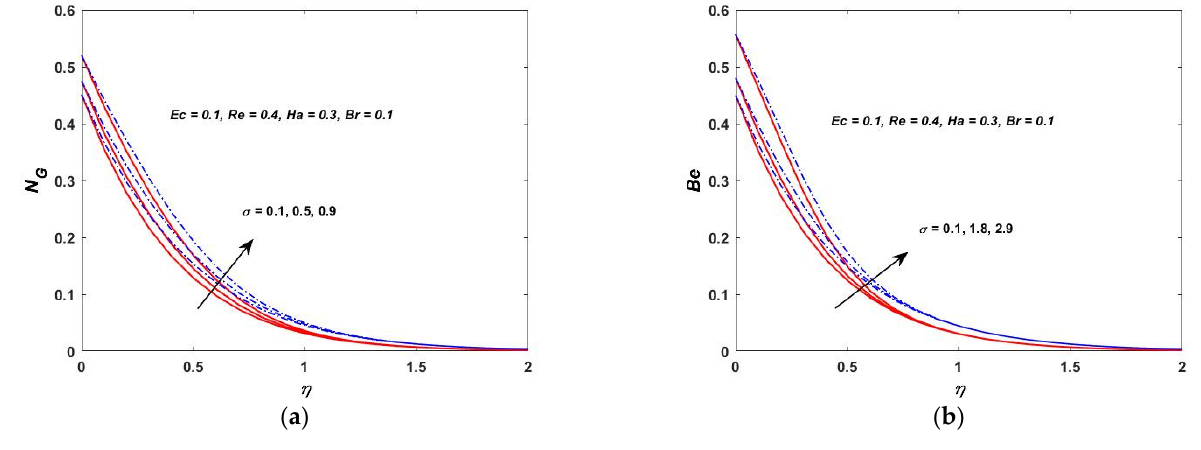
Figure 24. ( a ) Biot verses entropy N G . ( b ) Biot verses Bejan (Be).